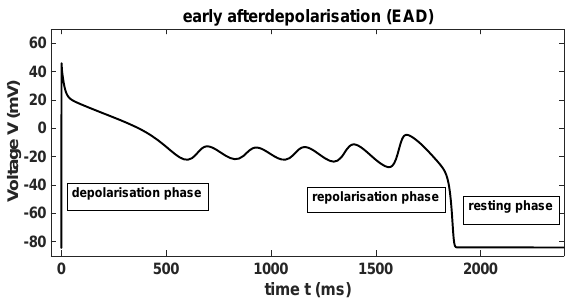
Figure 2. One example of an early afterdepolarisations